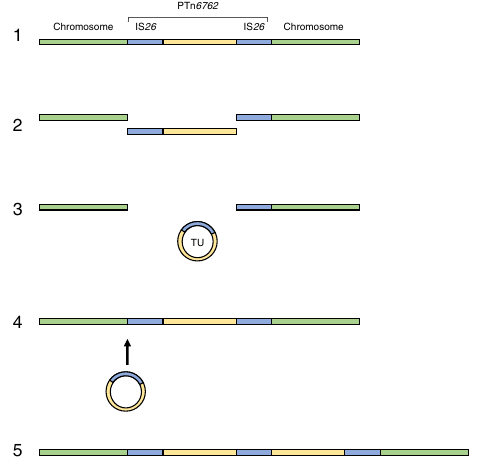
Fig. 5 Proposed mechanism of hyperproduction of TEM-1B mediated by IS 26 . Schematic of the proposed mechanism of ampli fi cation leading to hyperproduction of TEM-1B; (1) a pseudo compound transposon, PTn 6762 , is present on the chromosome fl anked by two copies of IS 26 . (2) PTn 6762 is excised from the chromosome, (3) which then forms a TU which (4) re- inserts into the chromosome adjacent to the chromosomally located IS 26 (5) creating a tandem array of the TU and increasing the copy number of bla TEM-1B